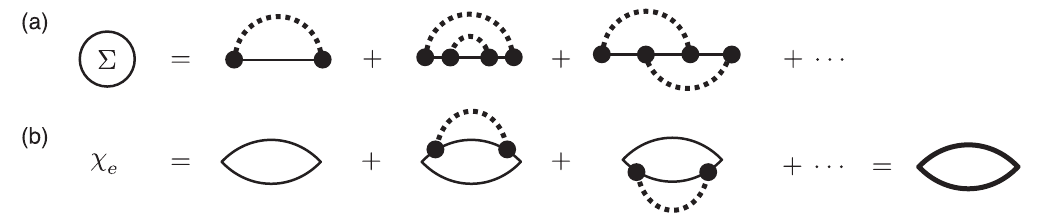
FIG. 8. Diagrammatic expansions. (a) First and second order diagrams for the electron-boson self-energy. (b) Diagrammatic representation of the electronic susceptibility in terms of the renormalized Green ’ s functions (thick